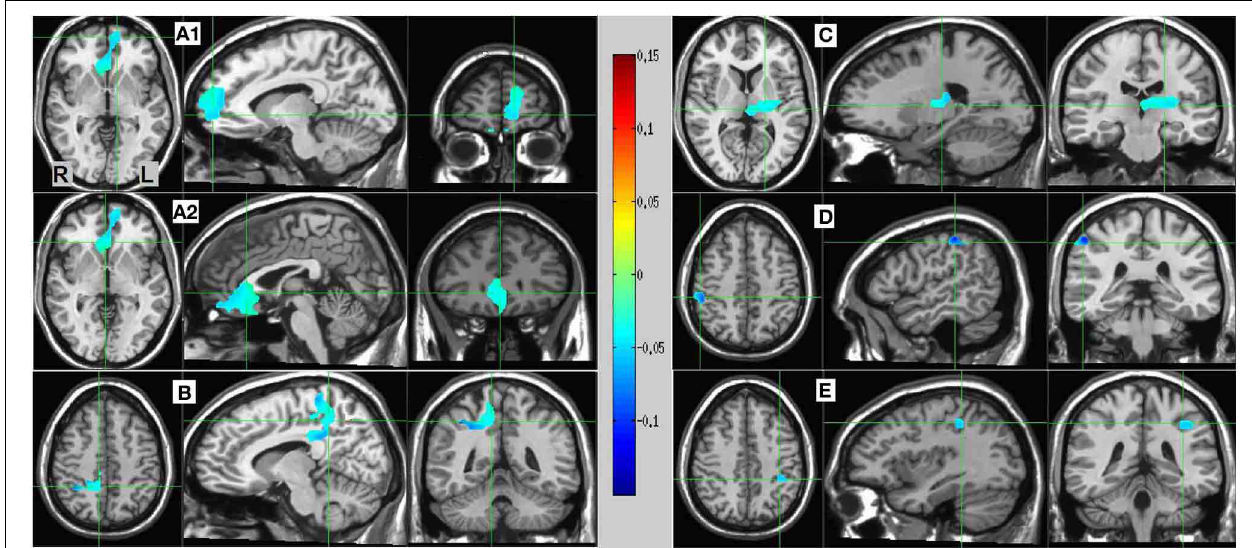
FIGURE 5 | MS vs. SL beamforming source estimates in the beta (13–25Hz) band. Axial, sagittal, and coronal views (left to right) of group ( N = 12) SAM pseudo- F source estimates overlayed on the Colin template. Note that in all images right and left sides are crossed. Color bar indicates PSC degree. Cluster A reveals prefrontal deactivations in two views: the crosshairs in (A1) are on the left